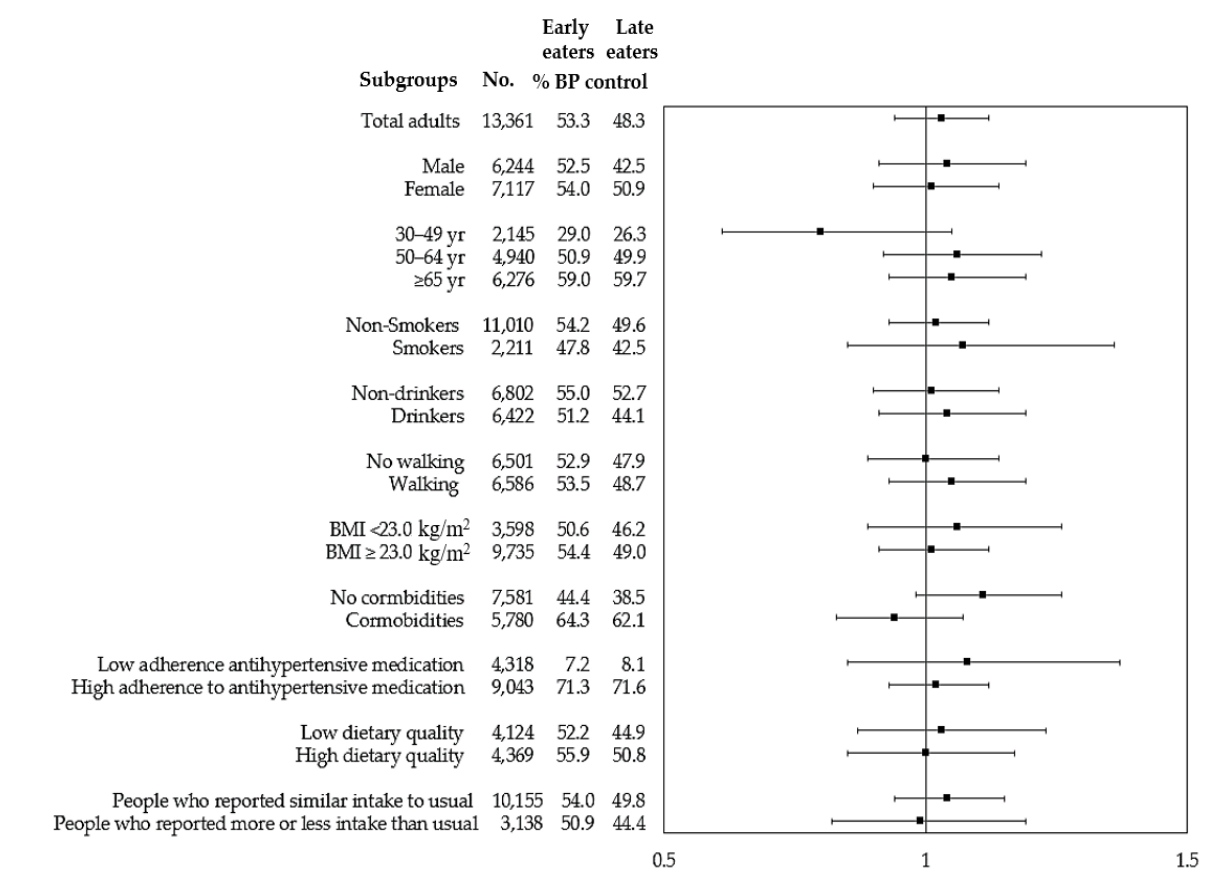
Figure 1. Subgroup analyses for associations of late eating with blood pressure control in hypertensive adults. ORs after adjustment for gen- der, age, shift work, smoking, drinking, walking, BMI, comorbid status, and adherence to antihypertensive medication. Data are presented as OR and 95% CI. The Korean Healthy Eating Index was available for the KNHANES 2013-2018 participants, and thus subgroup analyses for diet quality were performed using data of adults in 2013-2018 (n=8,493). OR, odds ratio; CI, confidence interval; KNHANES, Korea National Health and Nutrition Examination Survey. Table 4. Associations of late eating with cardiometabolic risk factors in adults with hypertension Cardiometabolic risk Variables